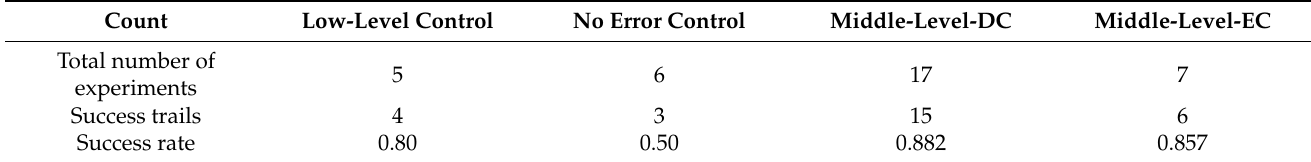
Table 2. Overview of online